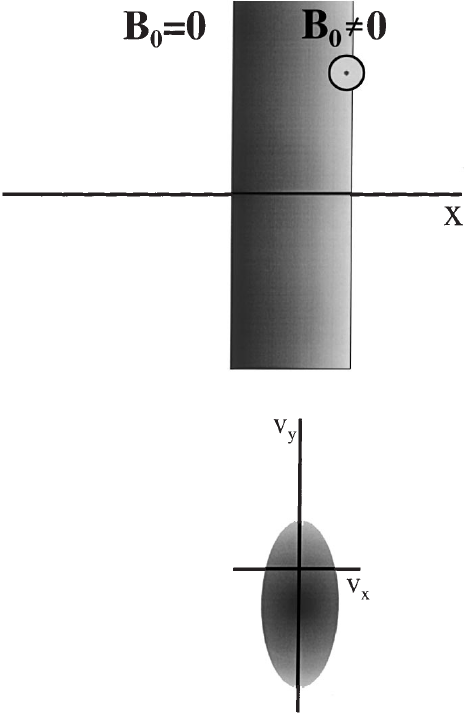
Fig. 3. Sketch of nongyrotropic distribution function in the magnetic boundary layer of a magnetic halfspace